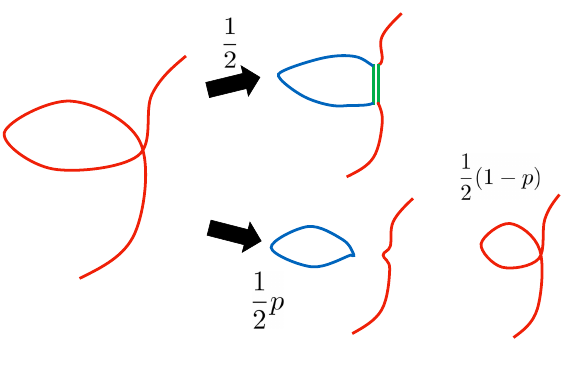
Figure 8 . Self-intersection of a superconducting string. The Y-junction (green doubled line) is formed with probability 1 . Otherwise, it reconnects producing a small loop (blue line) or passes 2 through. The reconnection probability is p ∼ 1